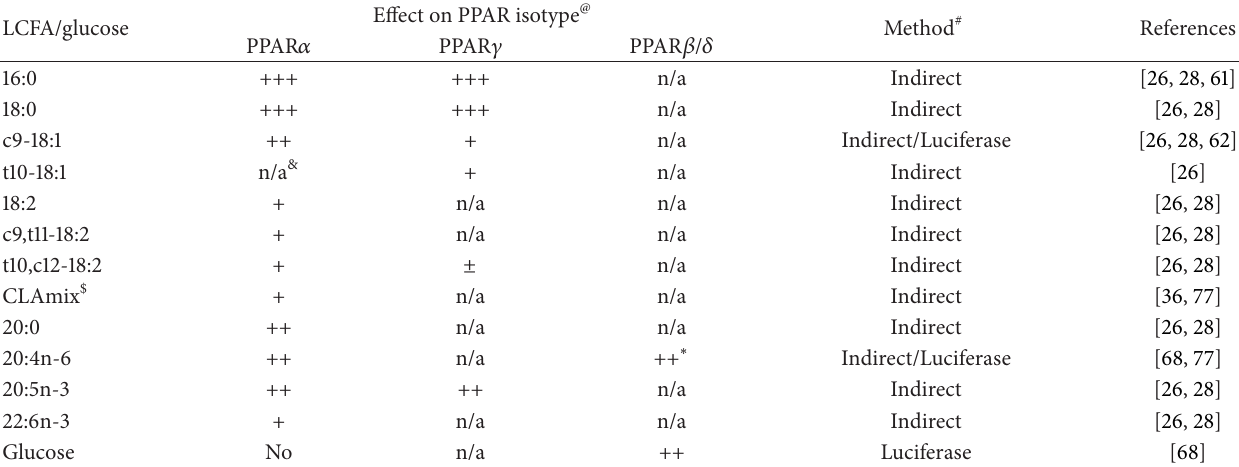
Table 1: Activation of PPAR isotypes in ruminants by main long-chain fatty acids or glucose.